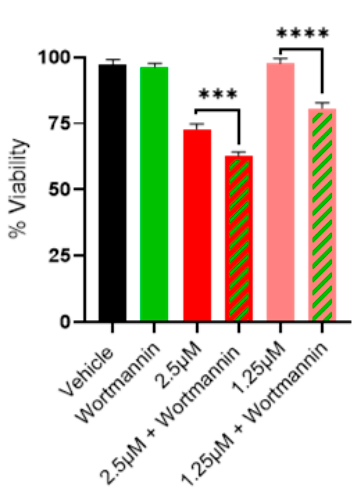
Figure 8. Increased PEI and NHC-Pt(II)-PEI toxicity with wortmannin co-treatment. CelltiterGlo 3D cell viability assay of NCH421K cells treated for 24 h with PEI or NHC-Pt(II)-PEI co-treated with 50 nM wortmannin (following 2 h pre-treatment with 50 nM wortmannin). Vehicle control corresponds to the equivalent highest amount of solvent added. Values represent the mean of at least n = 3 independent experiments ± one SEM. Statistics represent Student’s t -tests. Distribution normality was confirmed using a Shapiro–Wilk test. *** = p ≤ 0.001. **** = p ≤ 0.0001.